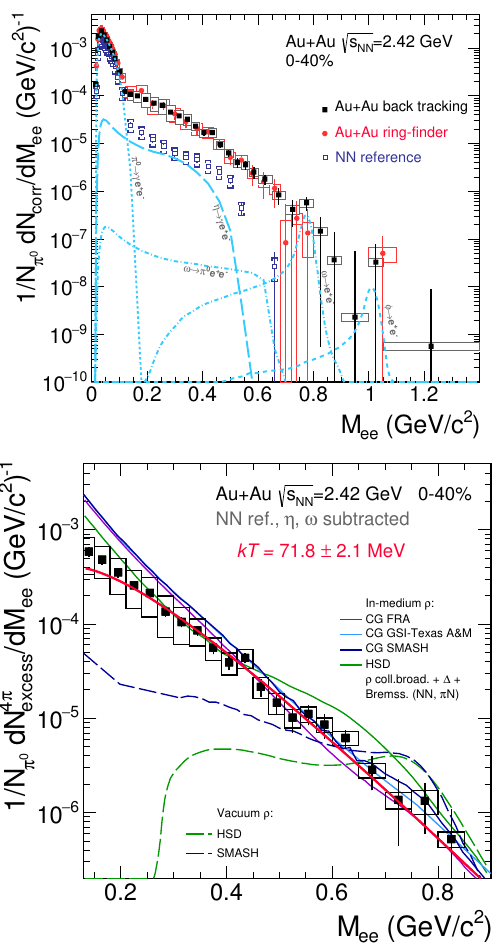
Figure 4. Top: Dielectron invariant mass distribution measured in Au + Au collisions compared to the freeze-out contribution from mesonic sources and the radiation from first chance bary- onic contributions ( N − N -reference)(see text for details). Bot- tom: Dielectron excess yield extracted by subtracting the meson contributions as well as the N − N reference normalized to the number of neutral pions. Red curve:thermal fit, dashed curves: ρ -meson vacuum line shape from HSD [18] and from SMASH [19] transport model calculations normalized to the respective number of neutral pions. Solid green curve: incoherent sum of all contributions: Δ → Ne + e − , N − N and π − N bremsstrahlung and in-medium ρ (collisional broadening scenario) from HSD . The dark-blue [19], blue[20] and pink [12] are curves show the results of three versions of coarse-grained calculations using in ρ medium-spectral functions from microscopic calculations